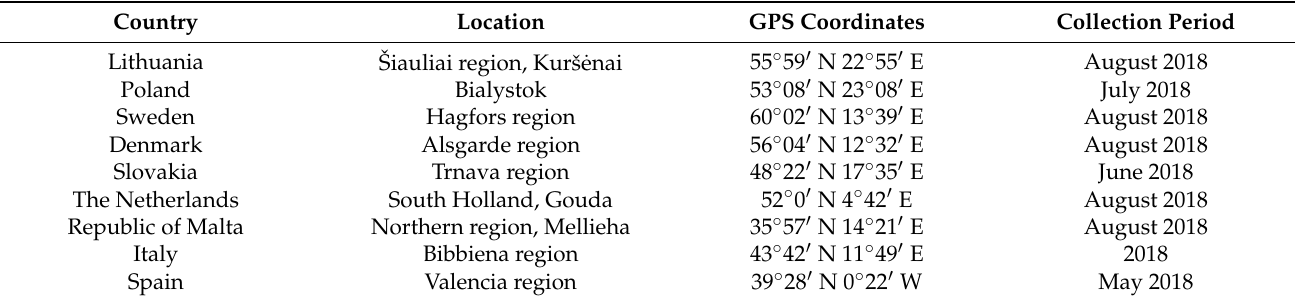
Table 1. Characterization of bee-collected pollen